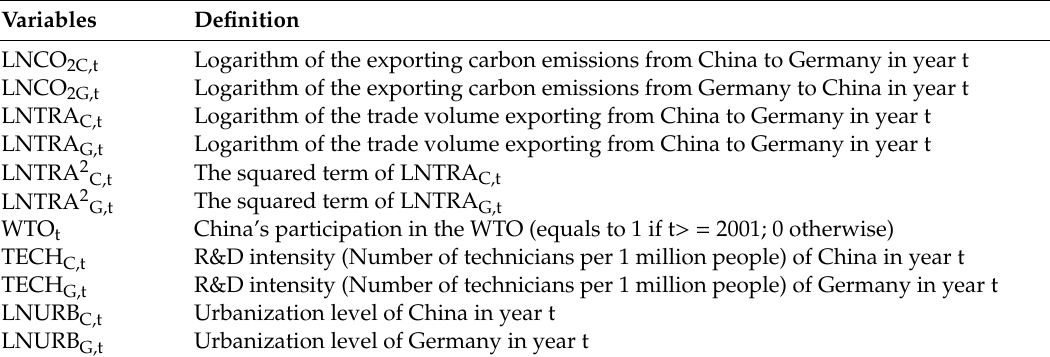
Table 1. Definition of the main variables.